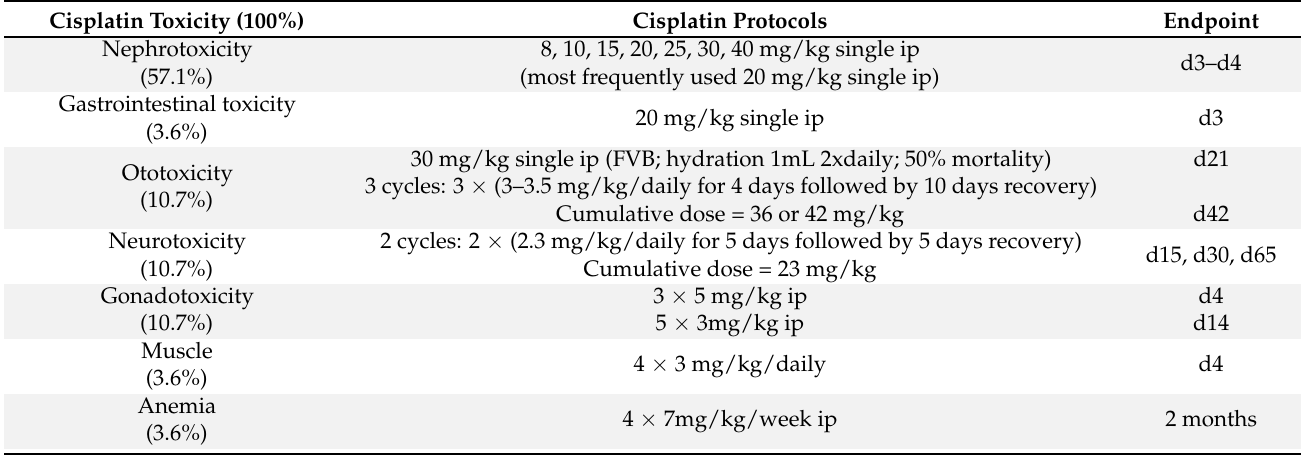
Table 1. Examples of mouse cisplatin toxicity protocols used in studies published from April 2020 to February 2021. Cisplatin Toxicity (100%) Cisplatin